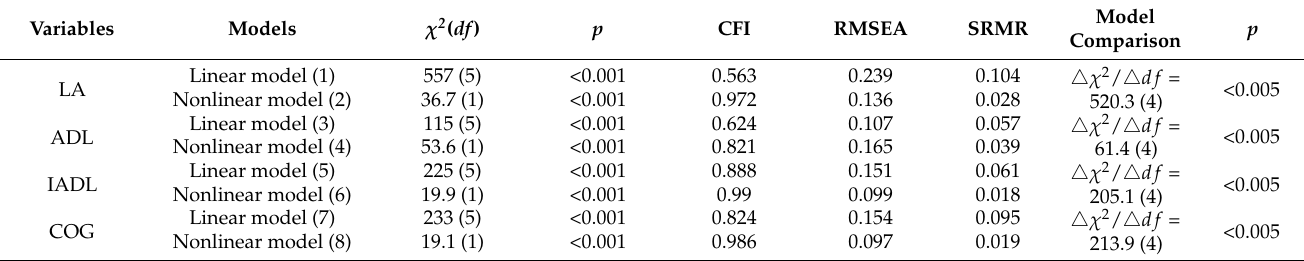
Table 2. Model fitting